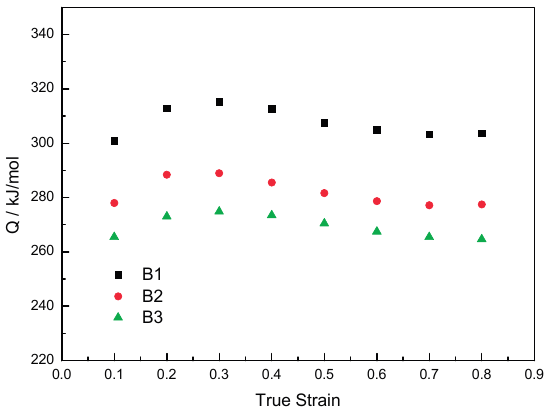
Figure 9. Effect of strain on activation energy of